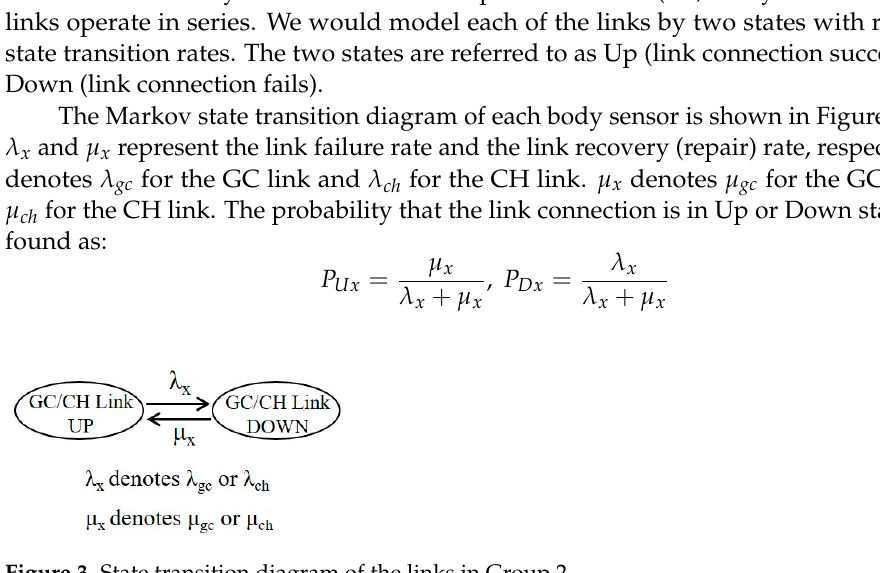
Figure 3. State transition diagram of the links in Group 2.